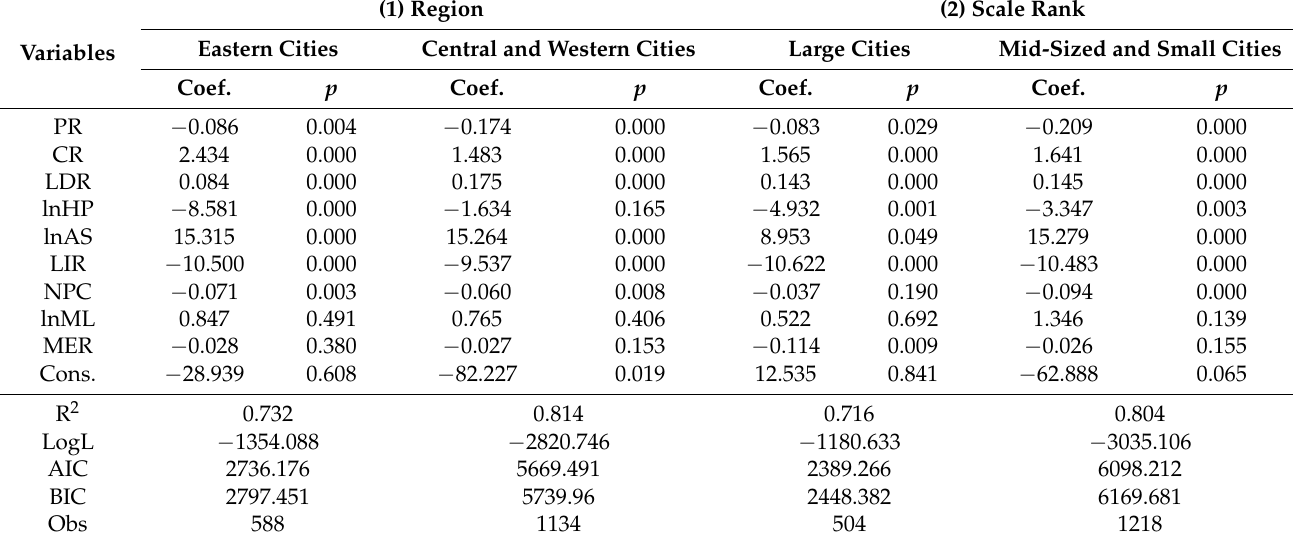
Table 6. Grouped regression estimation